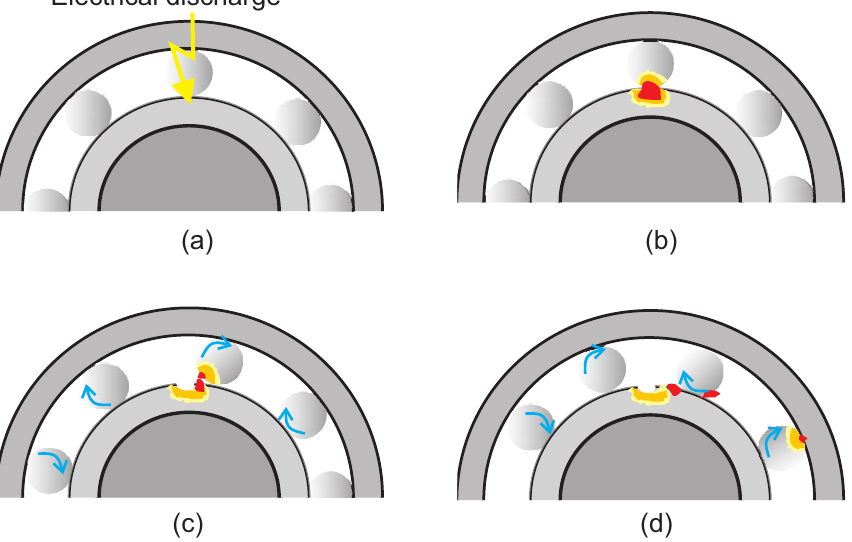
Figure 1. Electric arcing in a rolling bearing: ( a ) Electric current passes through rolling elements. ( b ) Arc welding occurs between the rolling elements and bearing race. ( c ) Molten material solidifies and separates. ( d ) Material excess is taken away due to rolling elements